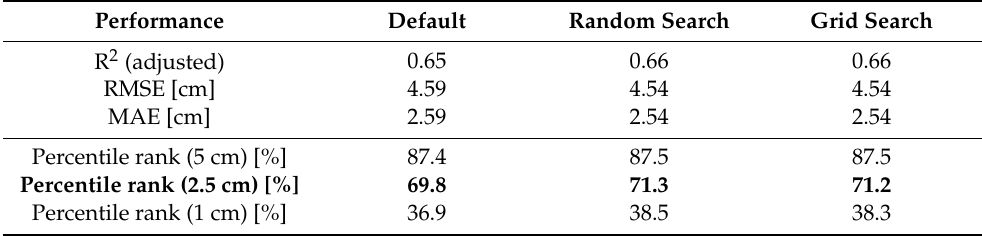
Table 6. Model 8 performance after hyperparameter tuning.